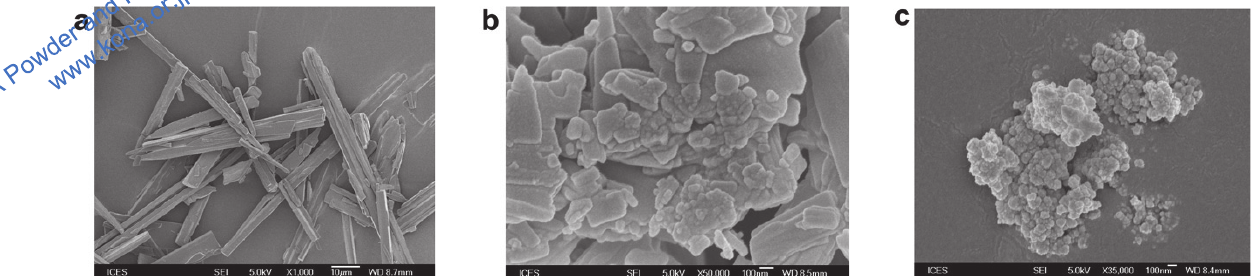
Fig. 3 Scanning electron microscopy (SEM) images of commercial trans -resveratrol particles (a) as well as after precipi- tation without (b) and with (c) HPMC 74) .